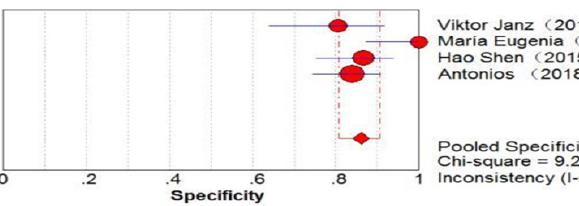
Figure 4. Forest plots of sensitivity of SF-BCB for PJI diagnosis